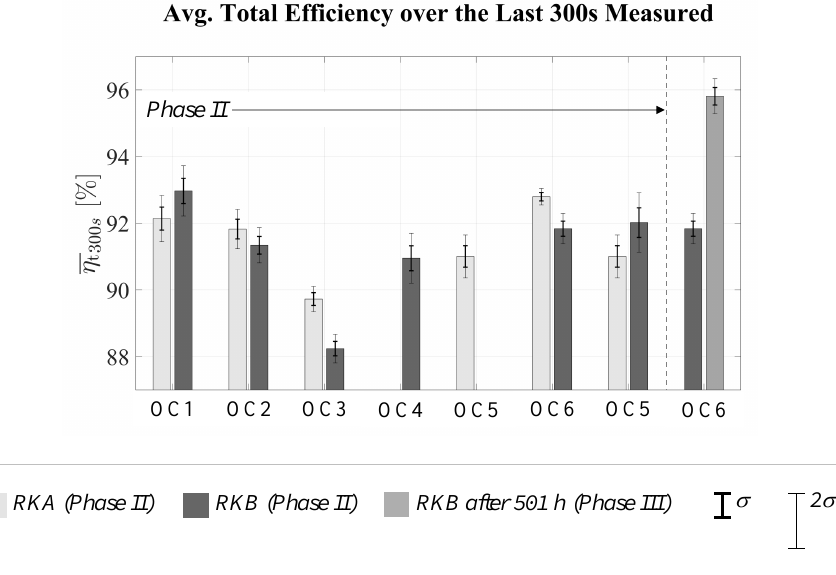
Figure 20. Average total efficiency over the last 5 min measured.